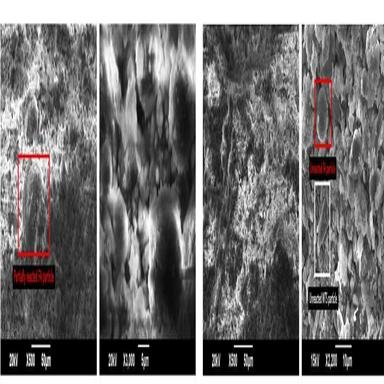
SEM images for the CLSM mixtures with 0.65 w/b, A of 5%, and varying WTS content levels.